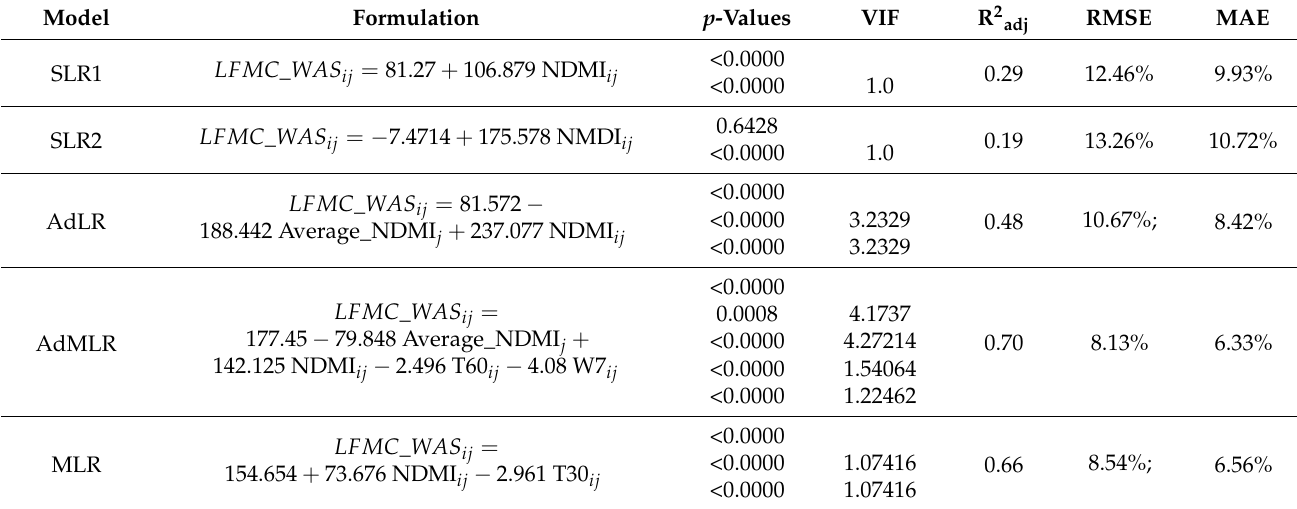
Table 5. Multiple regression models for LFMC_WAS. The columns represent: formulation, p -value of each coefficient, variance inflation factor (VIF), adjusted R 2 (R 2 adj ), root mean square error (RMSE), and mean absolute error (MAE).